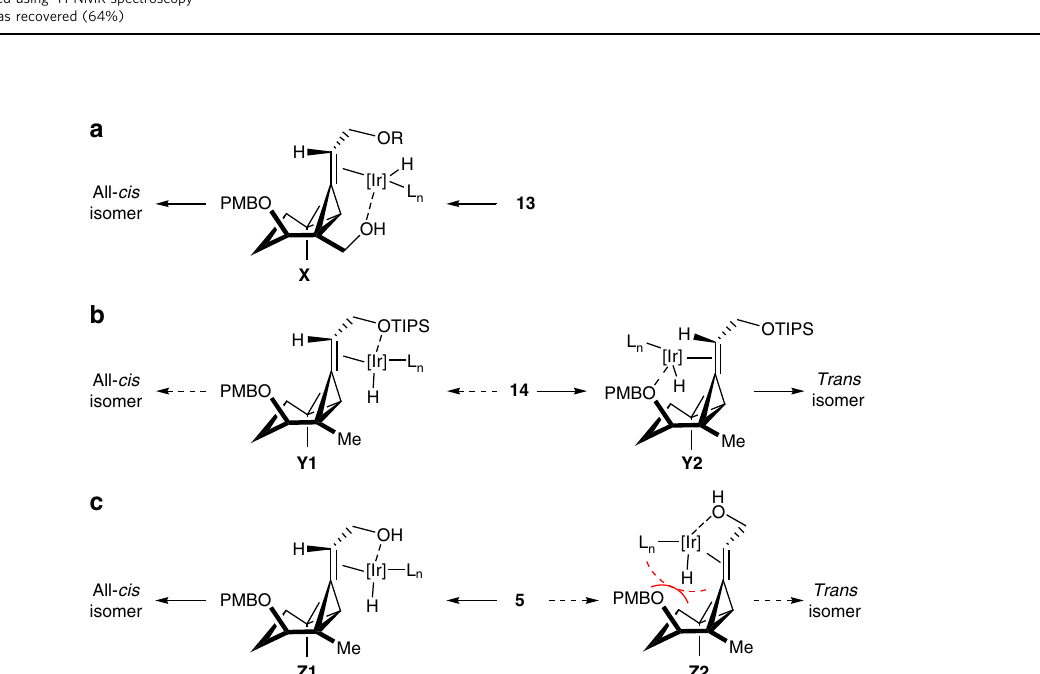
Fig. 4 Stereoselectivity of Ir-catalysed double-bond isomerisation. The stereoselectivity of the double-bond isomerisation could be controlled by the directing group. a The Ir catalyst coordinated preferentially to the alcohol moiety in 13 , resulting in the exclusive formation of the all- cis isomer. b Coordination to the TIPS ether was found to be less favourable than the PMB ether, resulting in the formation of the trans isomer through intermediated Y2 . c After the coordination of the alcohol to the catalyst, the reaction proceeded through intermediate Z1 , which was favoured over Z2 because of steric